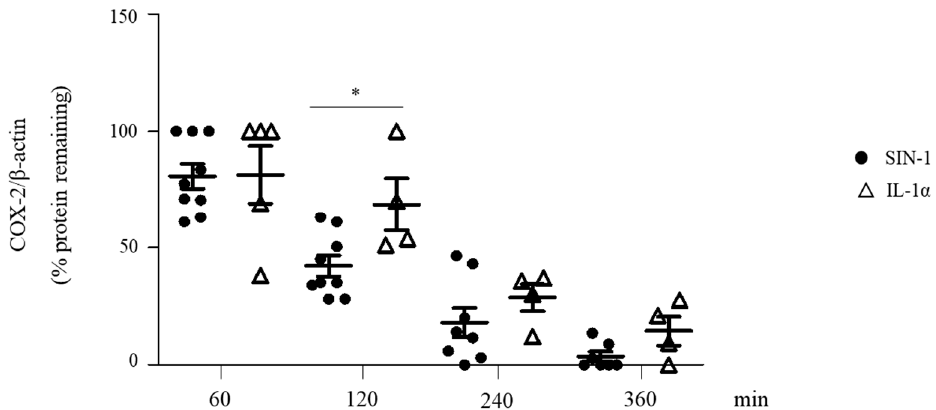
Figure 8. SIN-1 accelerates COX-2 degradation. HUVEC were treated with SIN-1 or IL-1 α for 18 h. After the addition of 2 µ g/mL cycloheximide (CHX), cells were incubated for different times (60, 120, 240, 360 min) and then harvest in lysis buffer. COX-2 expression was evaluated by Western blot analysis. β -actin was used as a control of protein loading. n = 4–9 independent experiments; * p < 0.05.